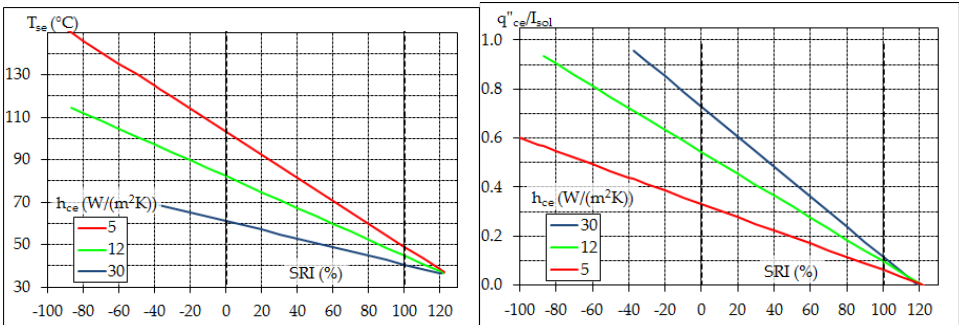
Figure 3. Surface temperature T se ( left ) and fraction of incident solar heat transferred to the near ground air ( right ) vs SRI with convection coefficient h ce for low, intermediate, or high wind speed and other standard conditions for SRI calculation (I sol = 1000 W/m 2 , T air = 310 K, T sky = 300